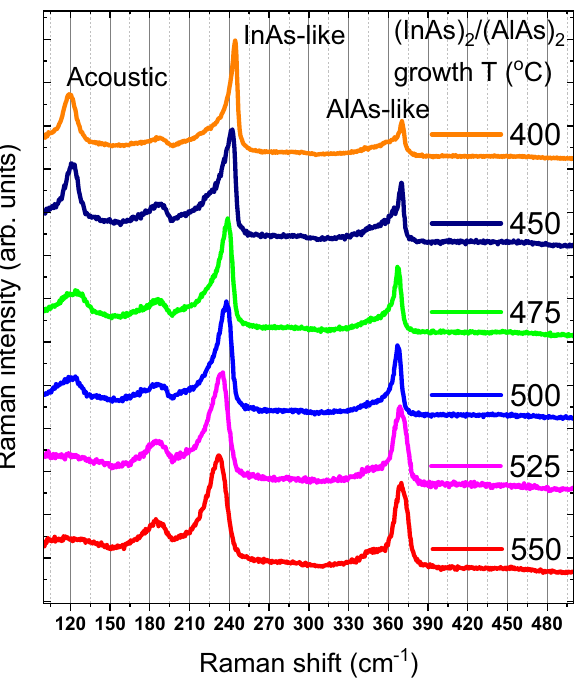
Figure 5. Raman spectra of (InAs) 2 /(AlAs) 2 SPSs grown at different temperatures from 400 to 550 °C. The InAs-like, AlAs-like, and acoustic phonon regions are